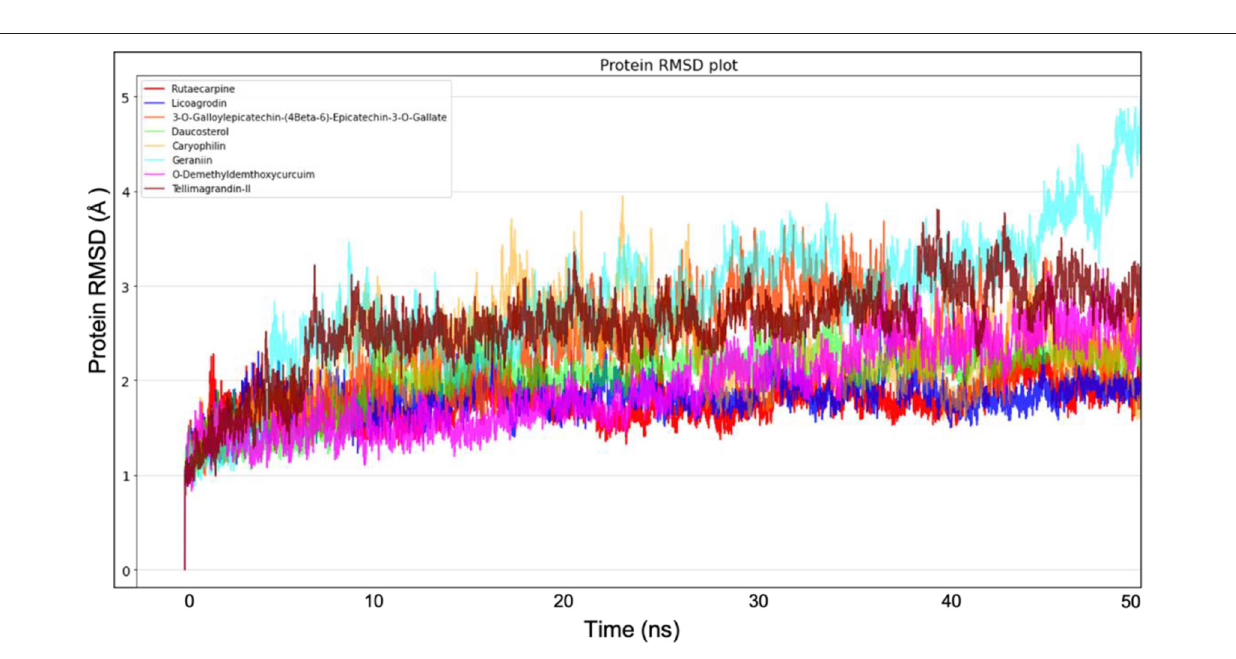
infectivity of SARS-CoV-2 showed reduction to almost 1,200- folds when both ASN331 and ASN343 were mutated in spike protein. This shows the significance of blocking these glycosylation sites on the receptor binding domain